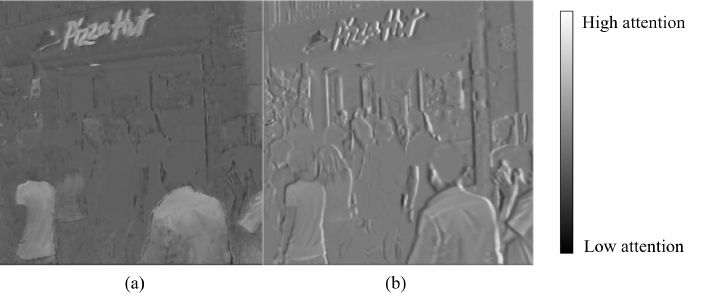
Figure 4. Example attention map of the RHA module. ( a ) The attention map M b obtained from the current blurry frame. ( b ) The attention map M s obtained from the previously recovered sharp